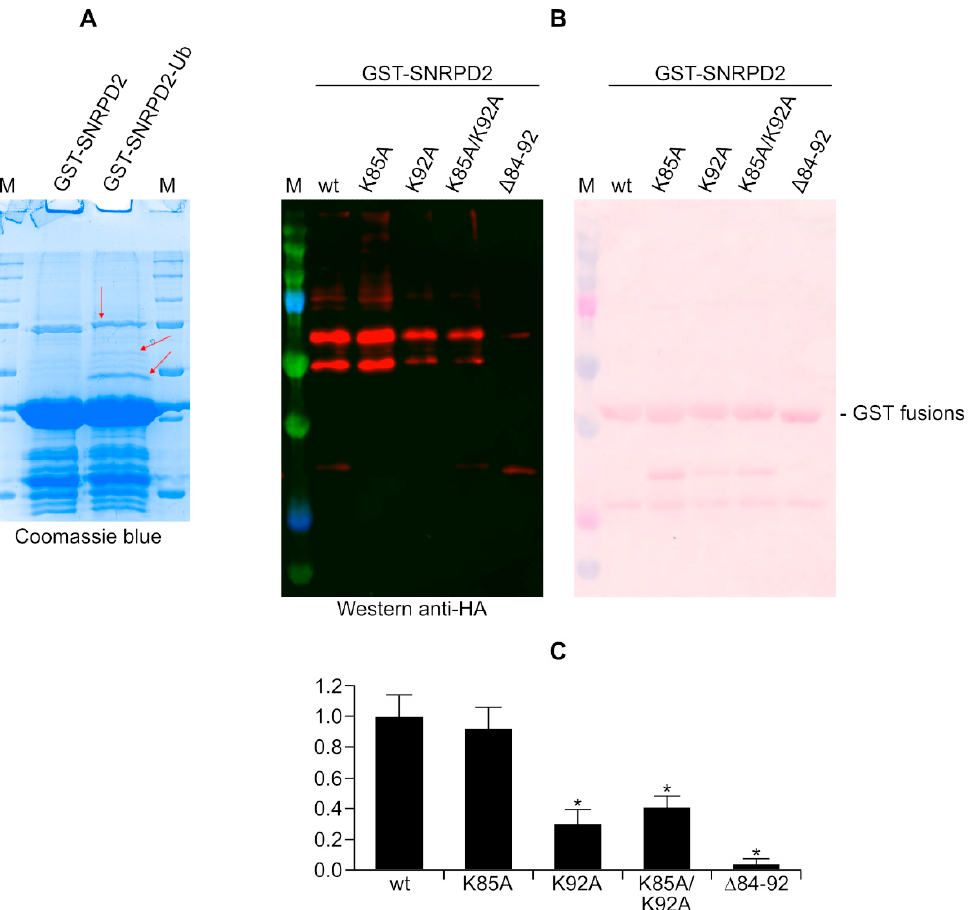
Figure 6. Identification of ubiquitinated residues in SNRPD2. ( A ) SDS-PAGE analysis of GST-SNRPD2 and GST-SNRPD2 subjected to the in vitro ubiquitination assay (GST-SNRPD2-Ub). The gel was stained with Coomassie blue and bands indicated by red arrows were cut for analyses by mass spectrometry. ( B ) Ubiquitination reactions catalyzed by SlrP on GST-SNRPD2 carried out in the presence of HA-ubiquitin were analyzed by Western blot with anti-HA antibodies. Different versions of GST-SNRPD2 used are indicated: wild-type (wt), point mutants K85A, K92A and K85A/K92A and deletion mutant Δ 84-92. M, molecular weight markers (size of bands in kDa: 250, 150, 100, 75, 50, 37, 25, 20). ( C ) Quantification of ubiquitinated bands from three independent ex- periments. Means and standard deviations are represented relative to the wild-type values that were set to 1. *, p < 0.05, for comparison with the wild type using ANOVA with Dunnett’s post-hoc test.